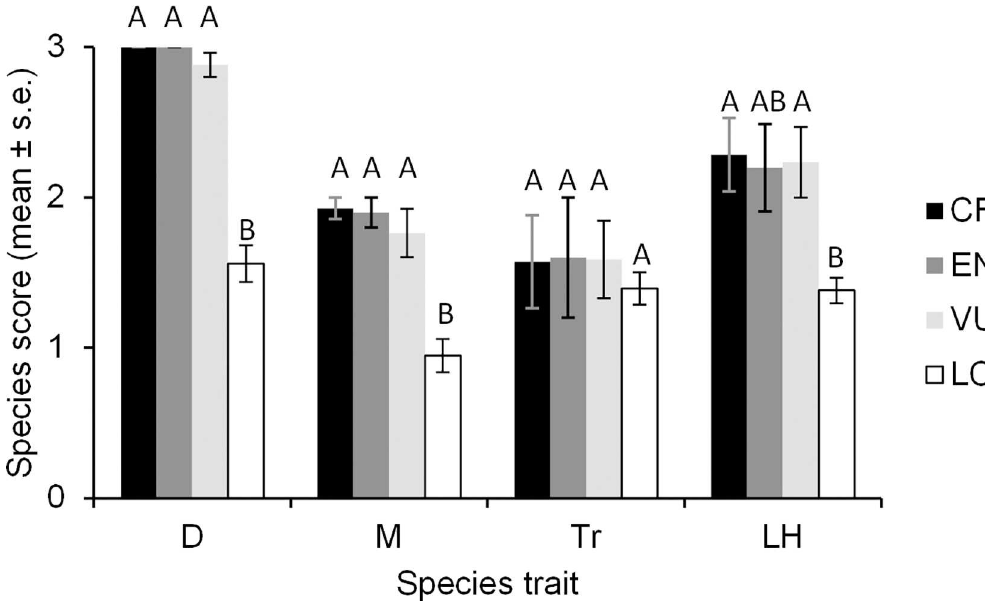
Fig 1. Bar graphillustrating traitdifferencesamongthe four categories of Red Listedspecies. Capitalletters indicatesignificant differences froma Tukey-Kramer-Nemenyi post-hoctest conductedfollowing a Kruskal-Wallis global test. CR = CriticallyEndangered, EN = Endangered, VU = Vulnerable; LC = Least Concern.D = Distribution score, M = Mobility, Tr = Trophic level, LH = Life History.